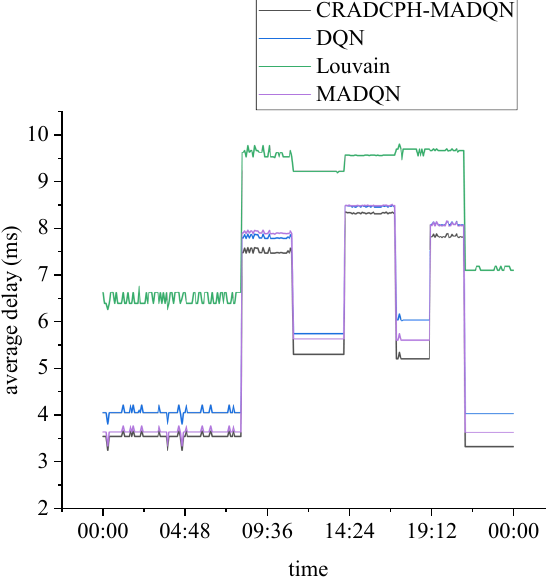
Figure 7. Root average delay.